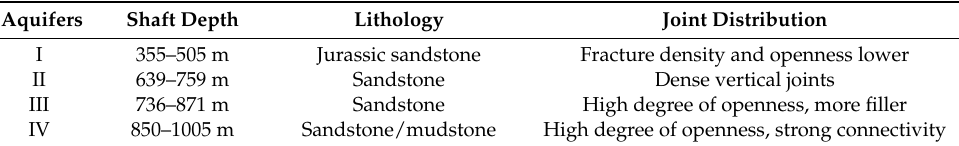
Figure 3. Lithological descriptions of the shaft. Table 1. Hydrogeologic nature of rock mass.